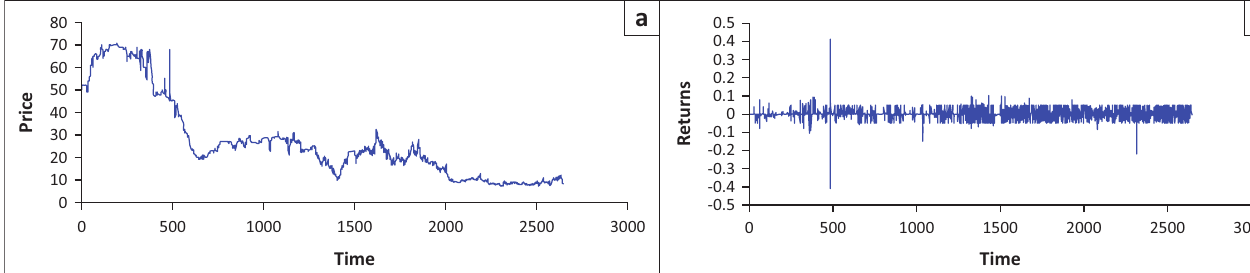
FIGURE 4: GlaxoSmith (a) stock pricing over time, (b) returns over time.